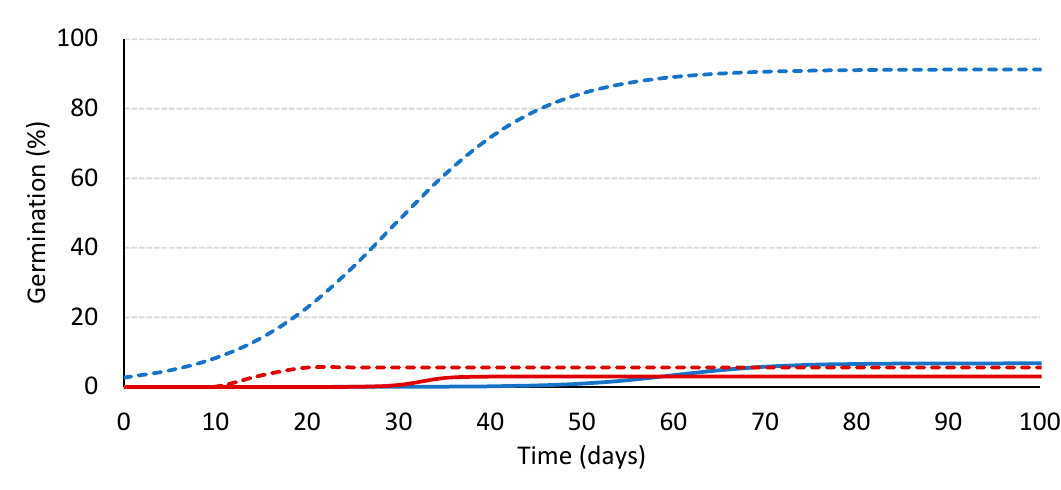
Figure 5. Logistic model fitted to cumulative germination curves of caper seeds. Mean values for the combinations of seed lot (owned seeds in blue lines, standard seeds in red lines) and the substrate saturation solution (water in continuous lines and the GA solution in dashed lines).